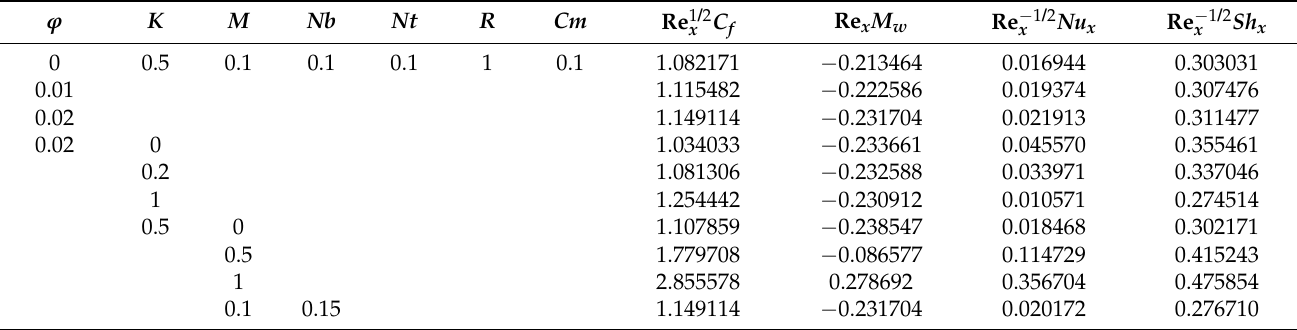
Table 4. Values of Re 1/2 x C f ,Re x M w ,Re − 1/2 x Nu x , and Re − 1/2 x Sh x for various parameters when